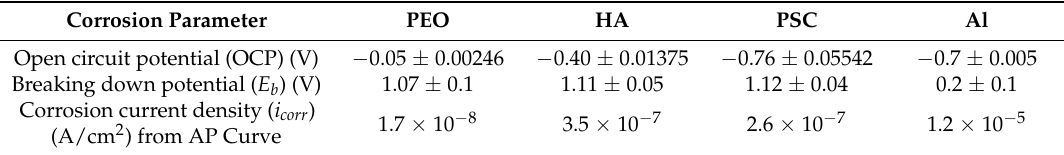
Figure 12. Optical images of coating surfaces after polarization tests for ( a ) Al, ( b ) HA, ( c ) PEO and ( d ) PSC coatings. Table 3. Summary of corrosion parameters of the